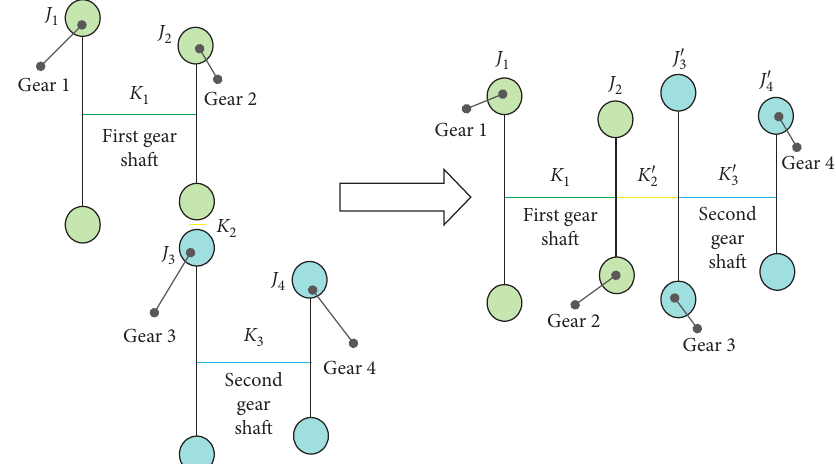
Figure 3: The schematic diagram of equivalent principle for simplifying a multimesh gear train into a chained